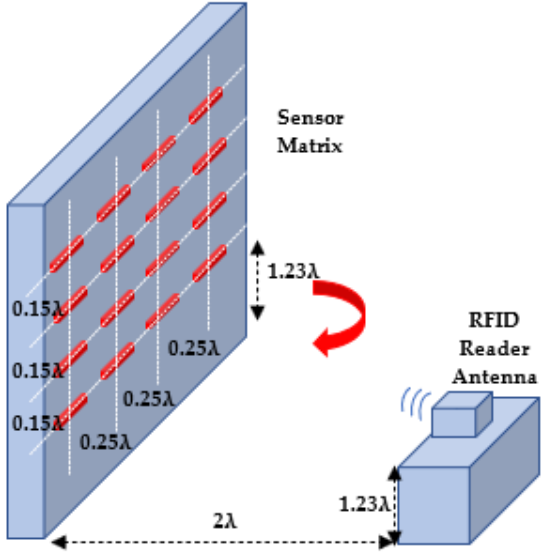
Figure 8. 2D RFID tag array setup for DOA measurements.